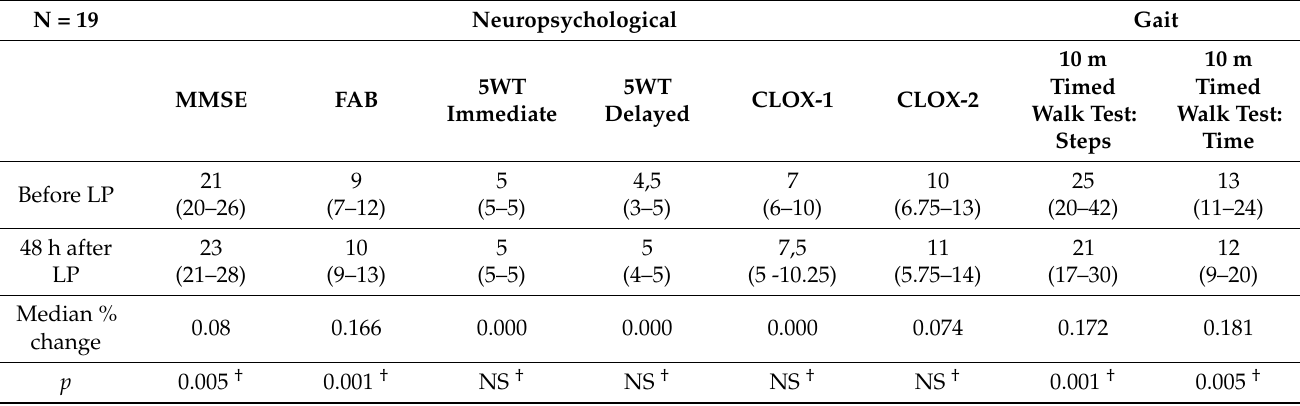
Table 3. Neuropsychological and gait data of tap test responders.